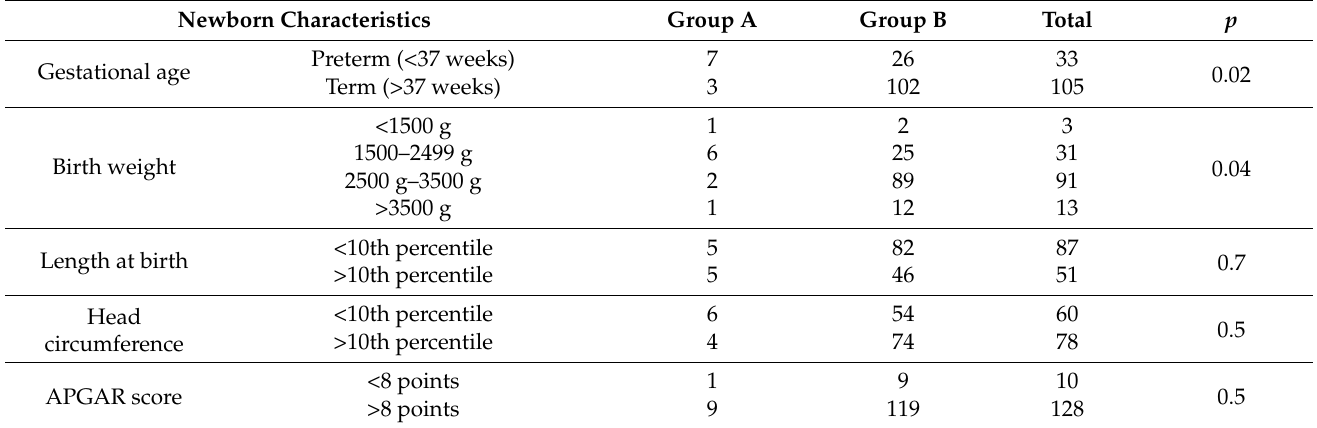
Figure 1. Incidence of mother-to-child transmission of HIV in CRC. Characteristics of the newborns are presented in Table 1. Table 1. Characteristics of the newborns from the studied groups.